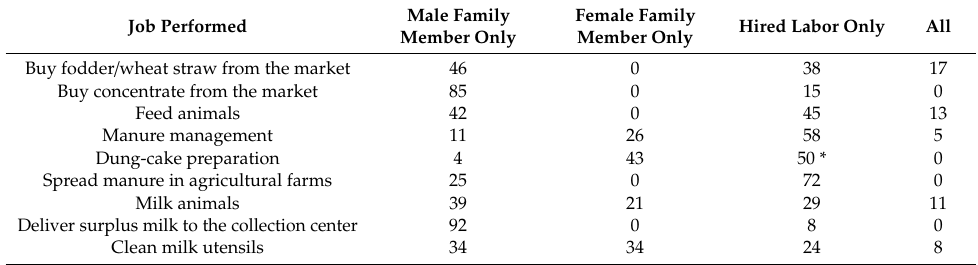
Table 6. Farmer responses: distribution (%) of dairy farm chores conducted / handled by family / hired labor and the respective gender roles obtained through farmer questionnaire survey during the study conducted on dairy value chains in Punjab, India, 2018–2019. Male Family Female Family Hired Labor Only All Job Performed Member Only Member Only Buy fodder / wheat straw from the